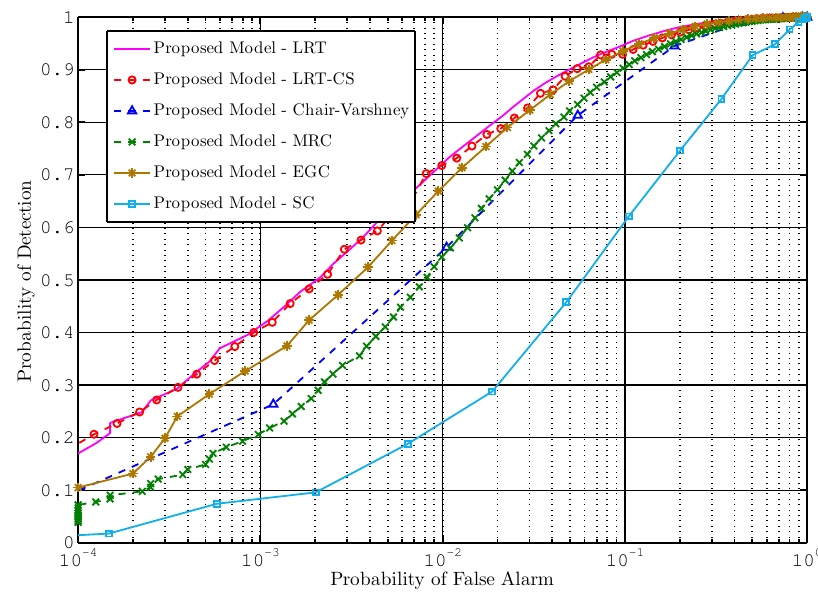
Figure 3. ROC curves for different fusion rules applied at the proposed WSN system model, average channel SNR = 5 dB, P d = 0.5, P f = 0.05 and total number of sensors K = 8.